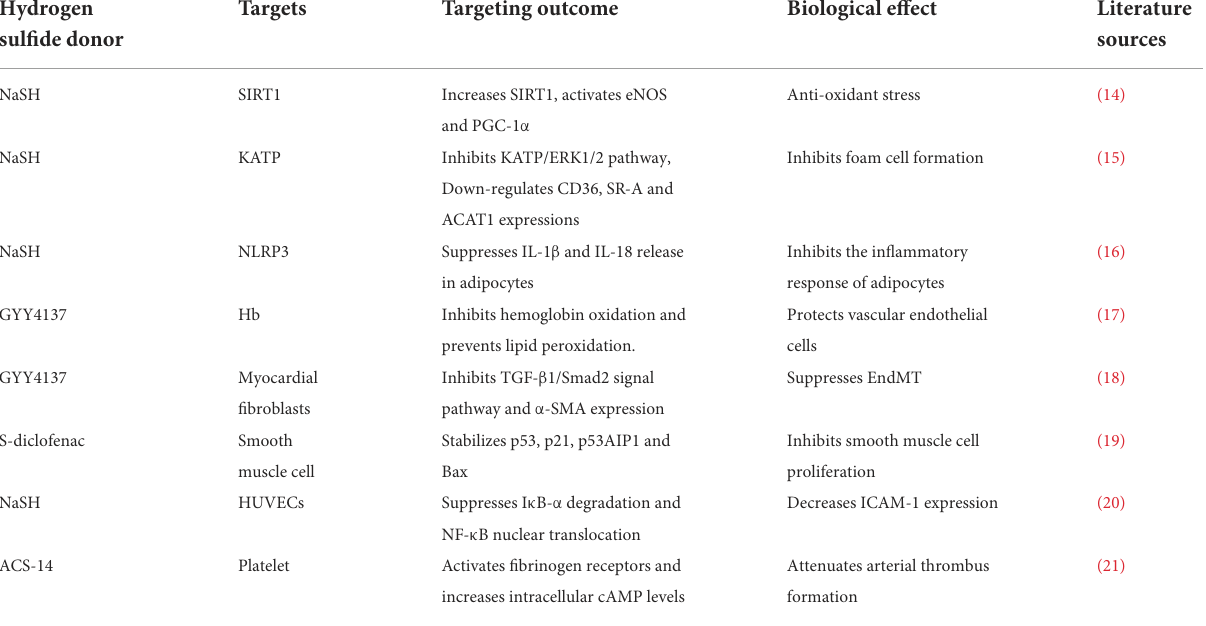
TABLE 2 Anti-AS effect of H 2 S from different